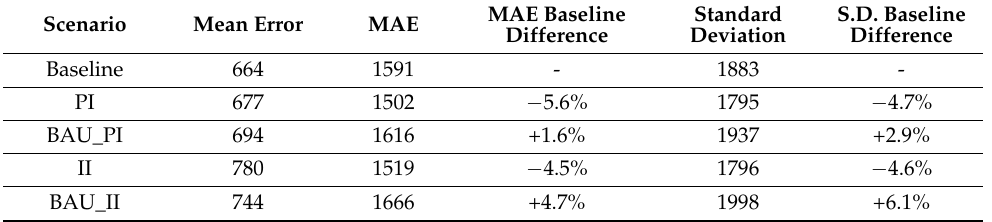
Table 8. Day ahead balancing actions (MW) for CCGT, OGCT and coal, showing that geographic and supply diversity reduces the need for balancing despite increased renewable